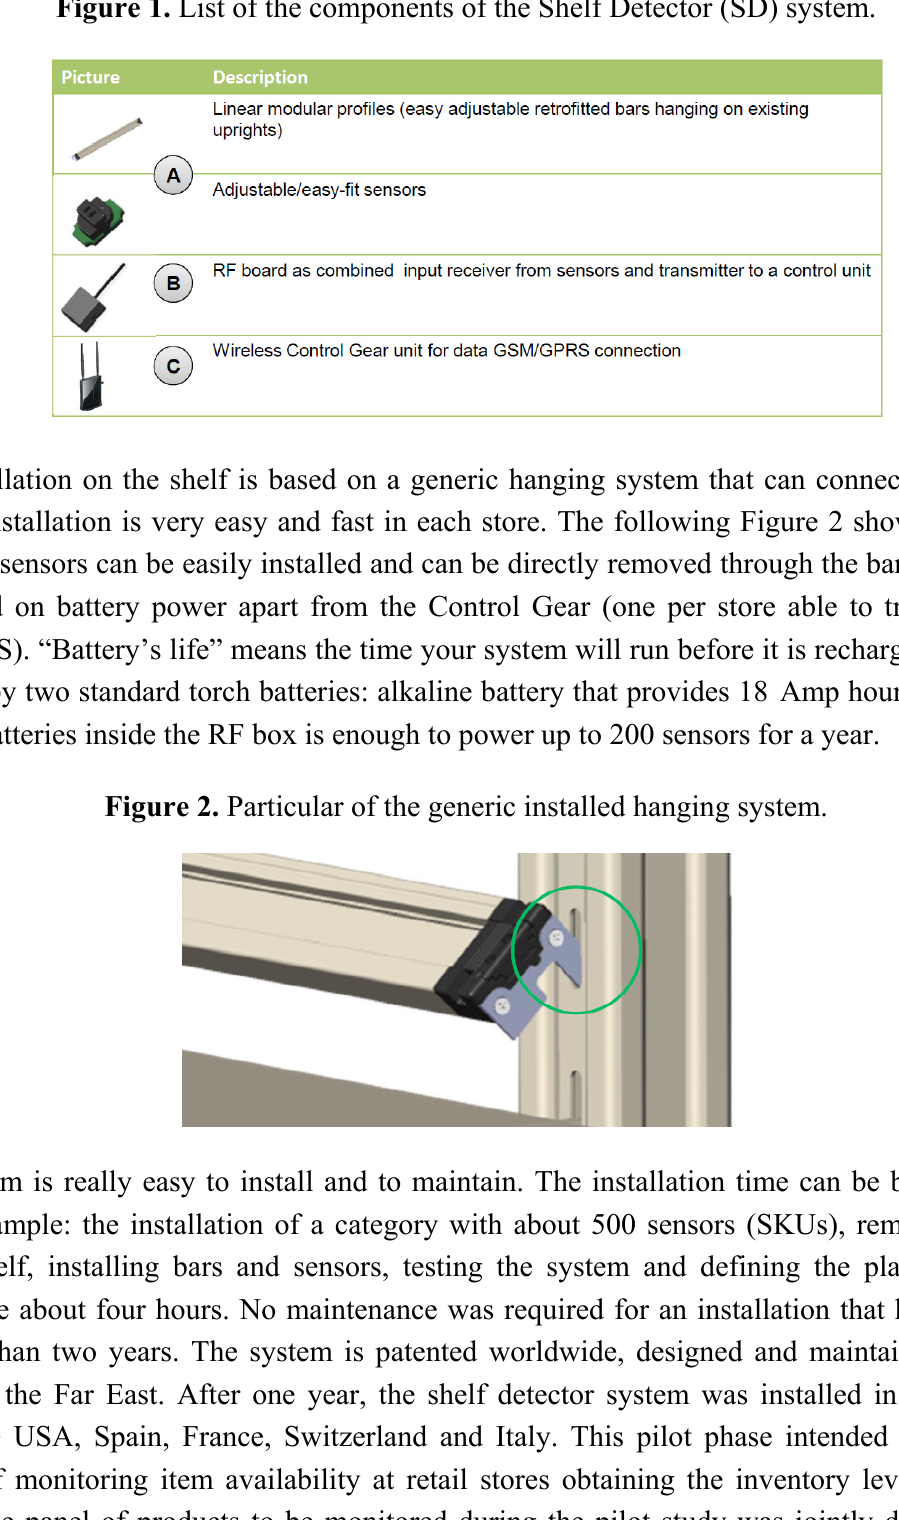
Figure 1. List of the components of the Shelf Detector (SD) system.